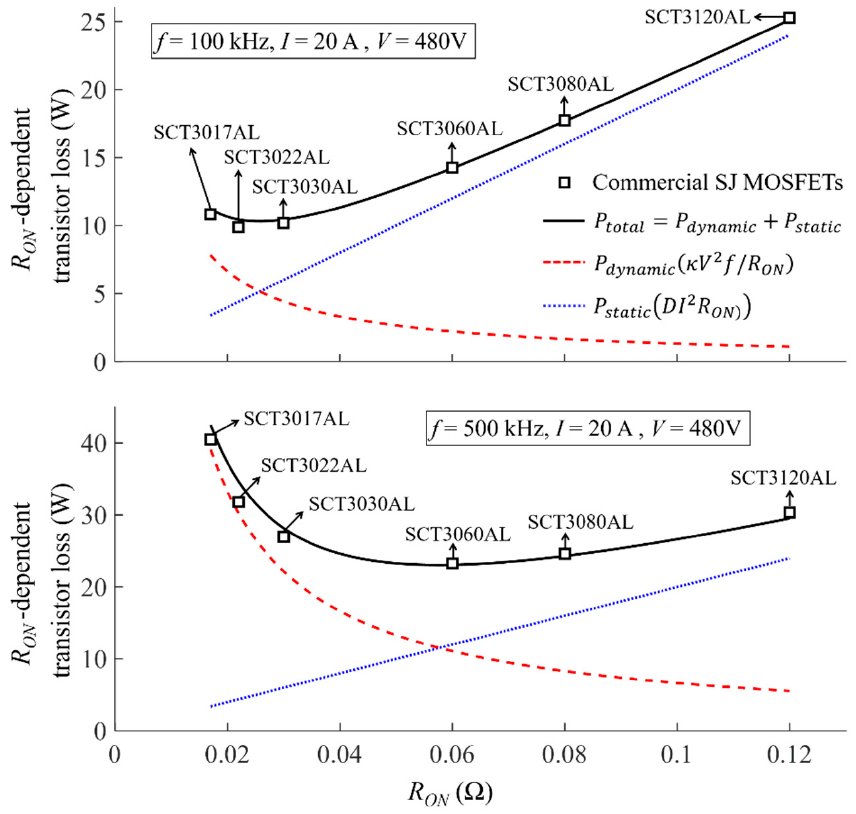
Figure 5. Comparison of the proposed theory at constant output current of 20 A with the commercial ROHM SiC MOSFETs.